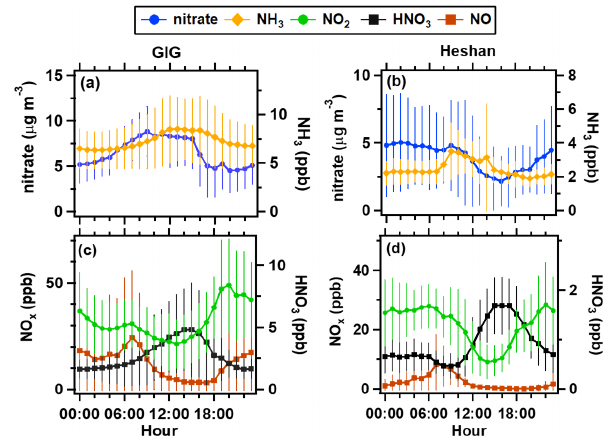
Figure 4. Diurnal variations of mean concentrations of nitrate and related pollution species at (a) GIG site and (b) Heshan site. The error bars represent the standard deviation of the